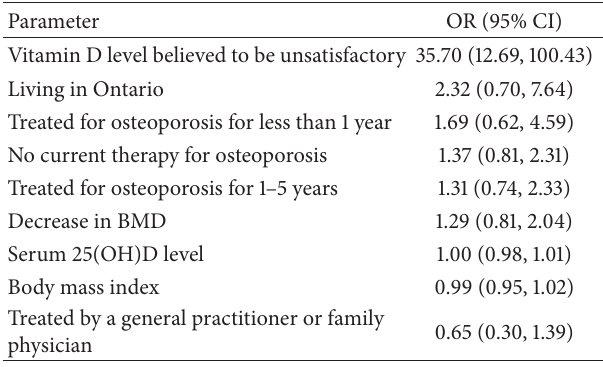
Figure 4: Physician evaluation of osteoporosis regimens. ∗ Based on answers to the question, “Is this patient’s BMD satisfactory (i.e., has there been no significant decrease in any measurement between the most recent and previous scans)?” (BMD = bone mineral density). ∗∗ Based on answers to the question, “Are this patient’s serum vitamin D levels adequate?” † Based on answers to the question, “If you answered ‘No’ to one of the above questions, does this patient require any changes to their medication?” Table 3: Results of multivariable GEE analysis examining potential associations with change in vitamin D